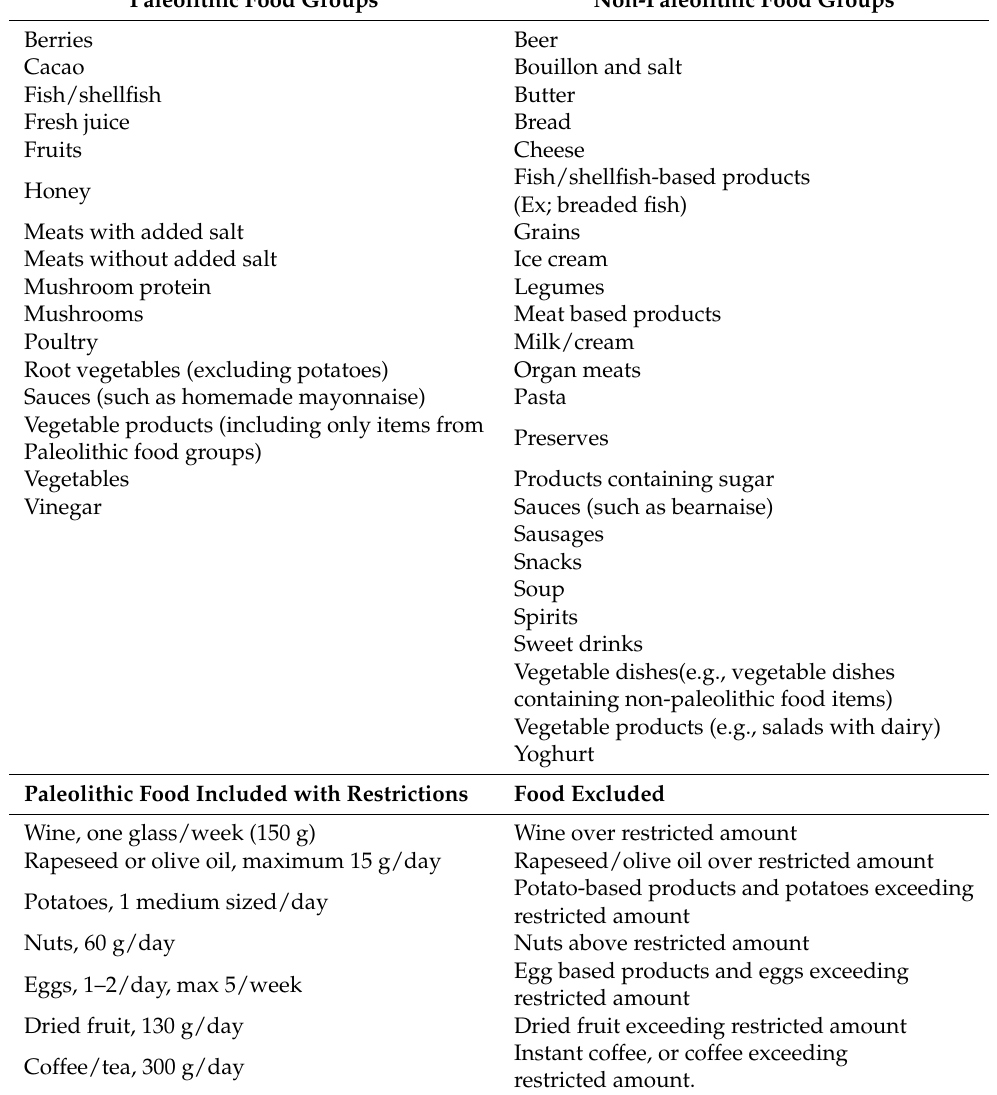
Table 2. Food items considered Paleolithic or not with eventual